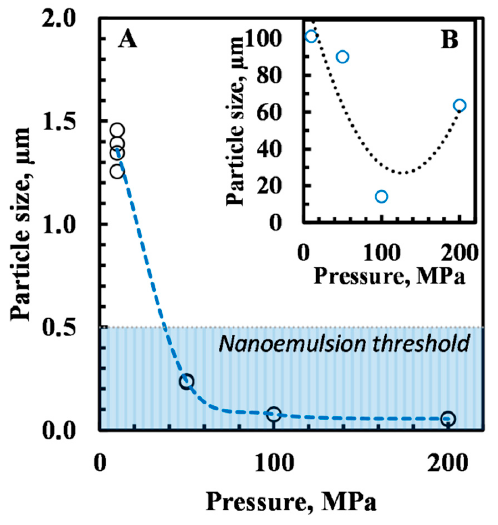
Figure 3. Surface mean diameter D [3,2] of emulsions prepared with 2% ( w/w ) WPI as a function of applied pressure at day 1 ( A ) and after 5 weeks of storage ( B